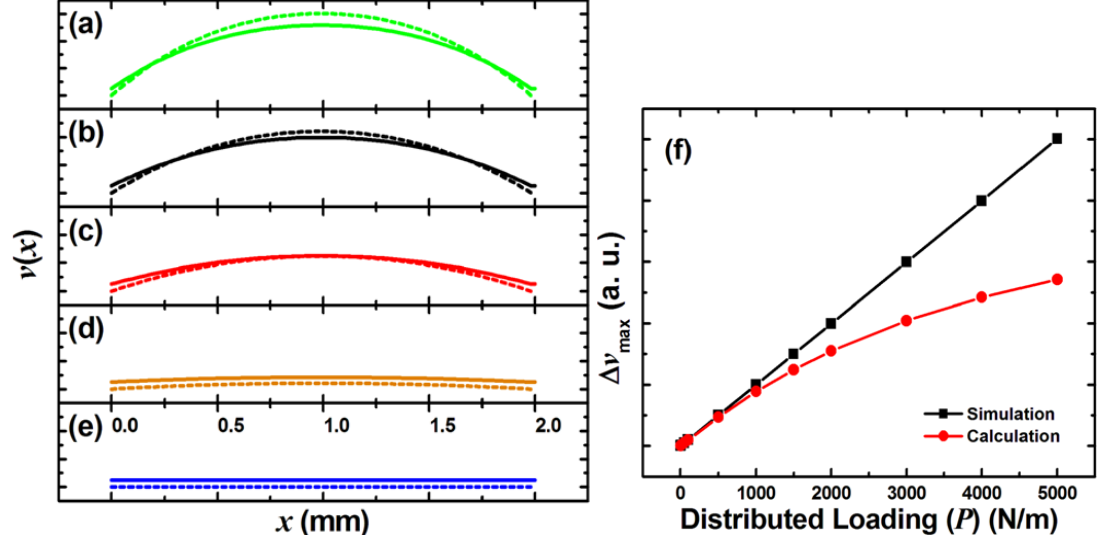
( a ) P = 2,000, ( b ) P = 1,500, ( c ) P = 750, ( d ) P = 300, and ( e ) P = 1 N/m with the upper layer (solid line) and the lower layer (dashed line) for each graph; ( f ) Distributed loading in real case implied a maximum displacement difference